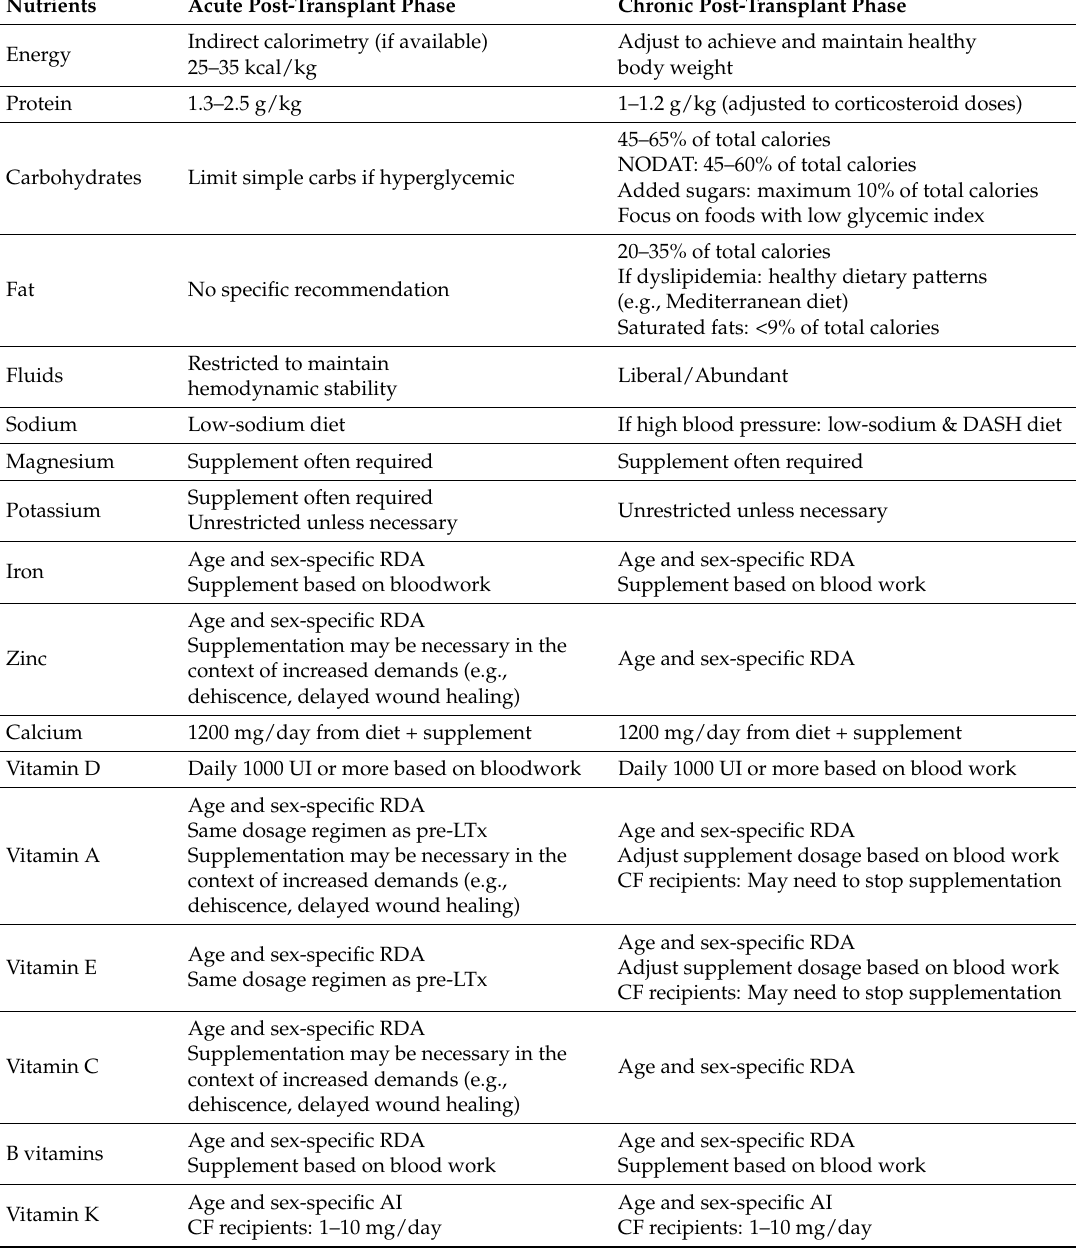
Table 1. Summary of nutritional requirements for lung transplant